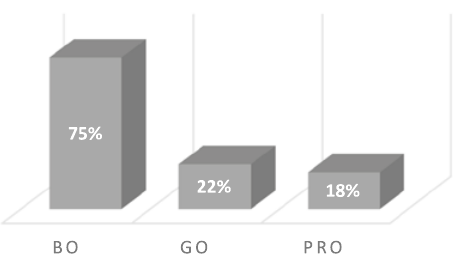
fig. 5. The percentage of participant recognising “Unaided decision making process” as a